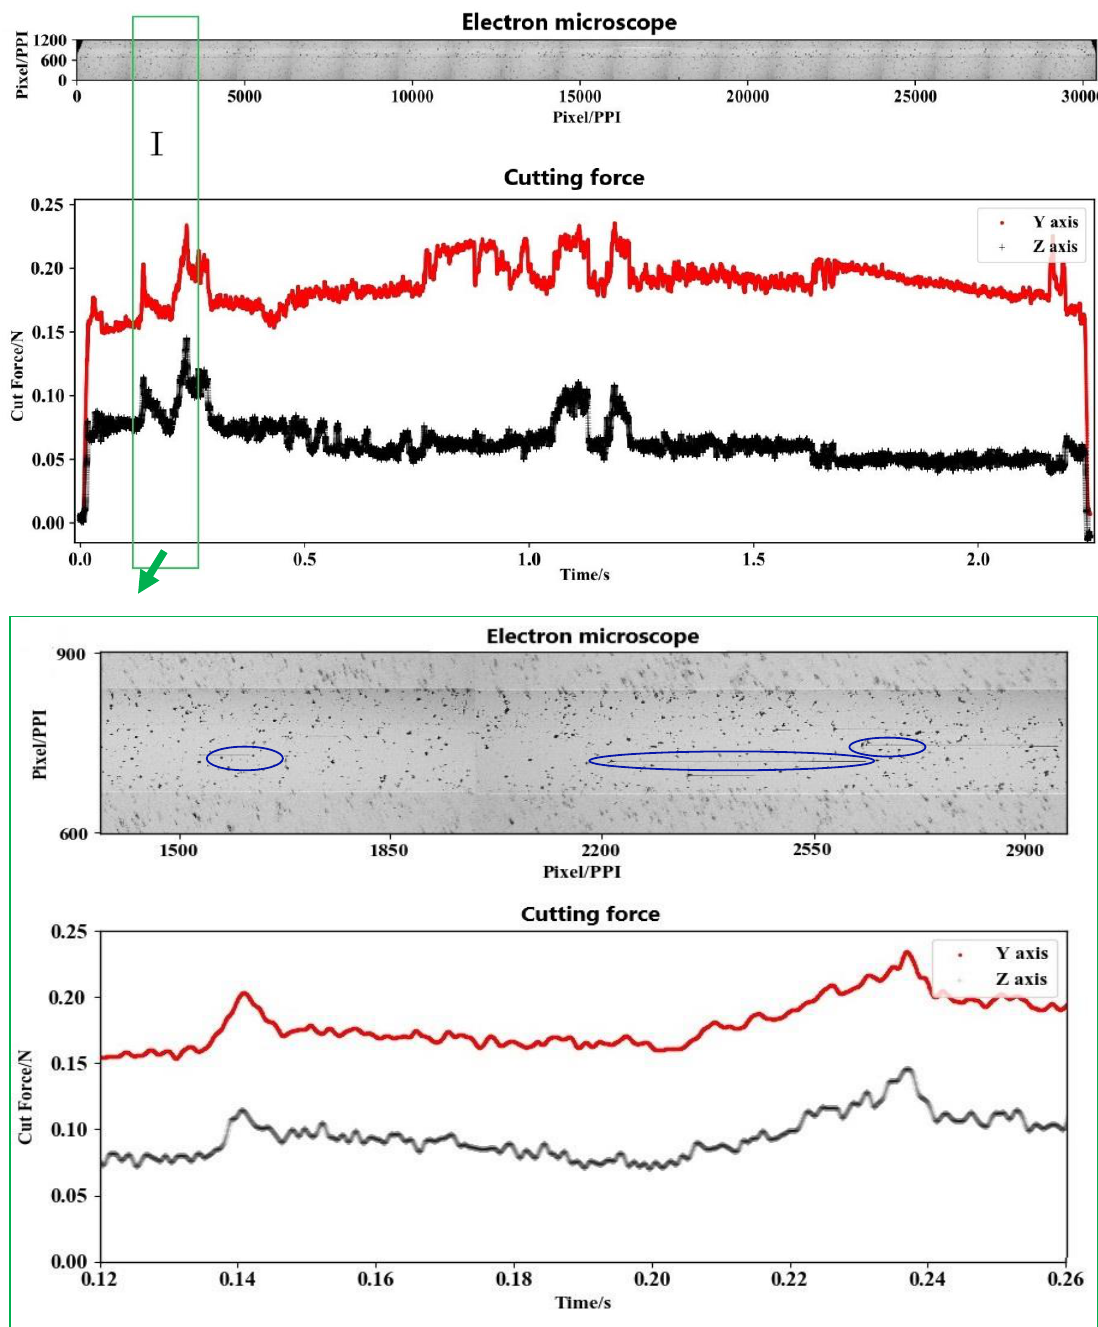
Figure 6. Force measurement in diamond cutting of Al6061.